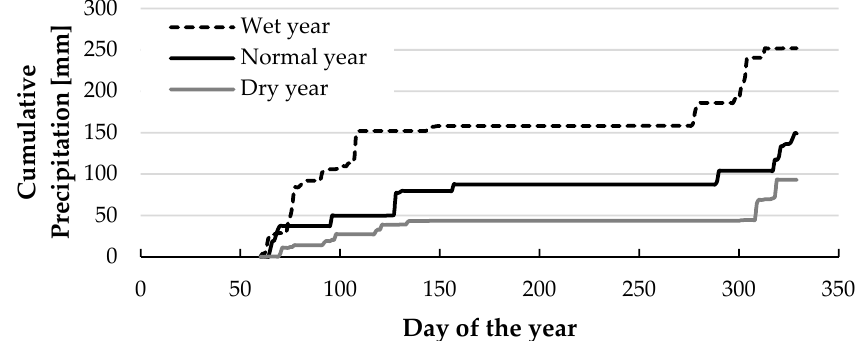
Figure 2. Cumulative precipitation at the station of Moires, Crete, during the dry season (March to November) for a Dry (D), Normal, and Dry (D) year. Table 1. Total precipitation and average temperature (cid:1846) at the station of Moires, Crete, during the dry season (March to November) for a Dry (D), Normal, and Dry (D) year and respective total (cid:1831)(cid:1846) (cid:2868) values calculated using Blaney-Criddle [37].